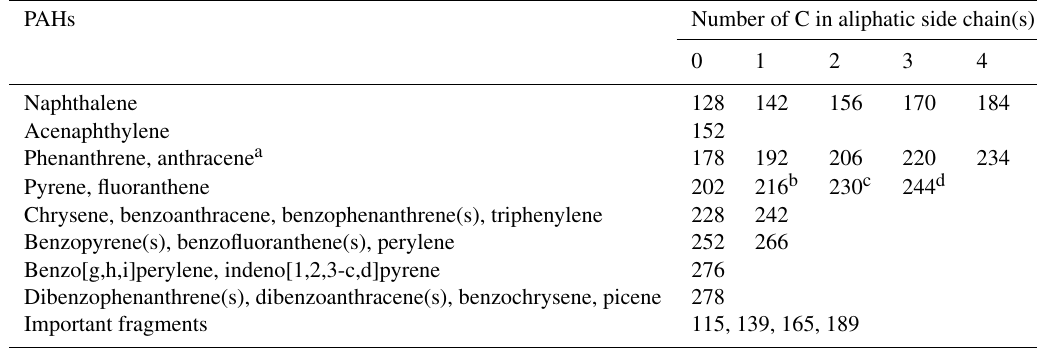
Table 1. Polycyclic aromatic hydrocarbons, indicated by the REMPI mass spectra ( m/z ). PAHs Number of C in aliphatic side